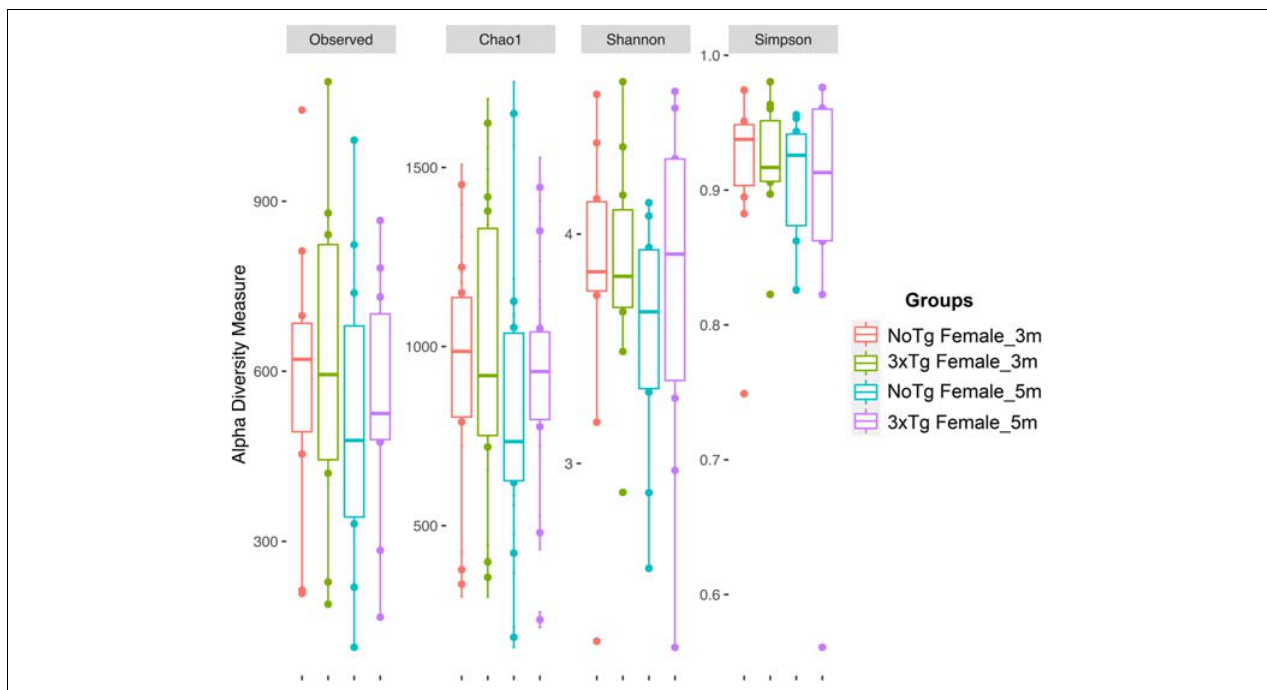
FIGURE 6 | Alpha diversity of bacteria in fecal samples collected from female mice. The figure shows data for non-transgenic (NoTg) (coral pink) and Alzheimer’s disease triple-transgenic (3xTg-AD) mice at 3 months (m) old (light olive) and NoTg (light blue) and 3xTg-AD mice at 5 months old (light purple). The Y -axis indicates the values for the corresponding indexes: observed number of species (Observed), expected bacterial richness (Chao1), and Shannon and Simpson diversity ( Supplementary Tables 3, 4 ).